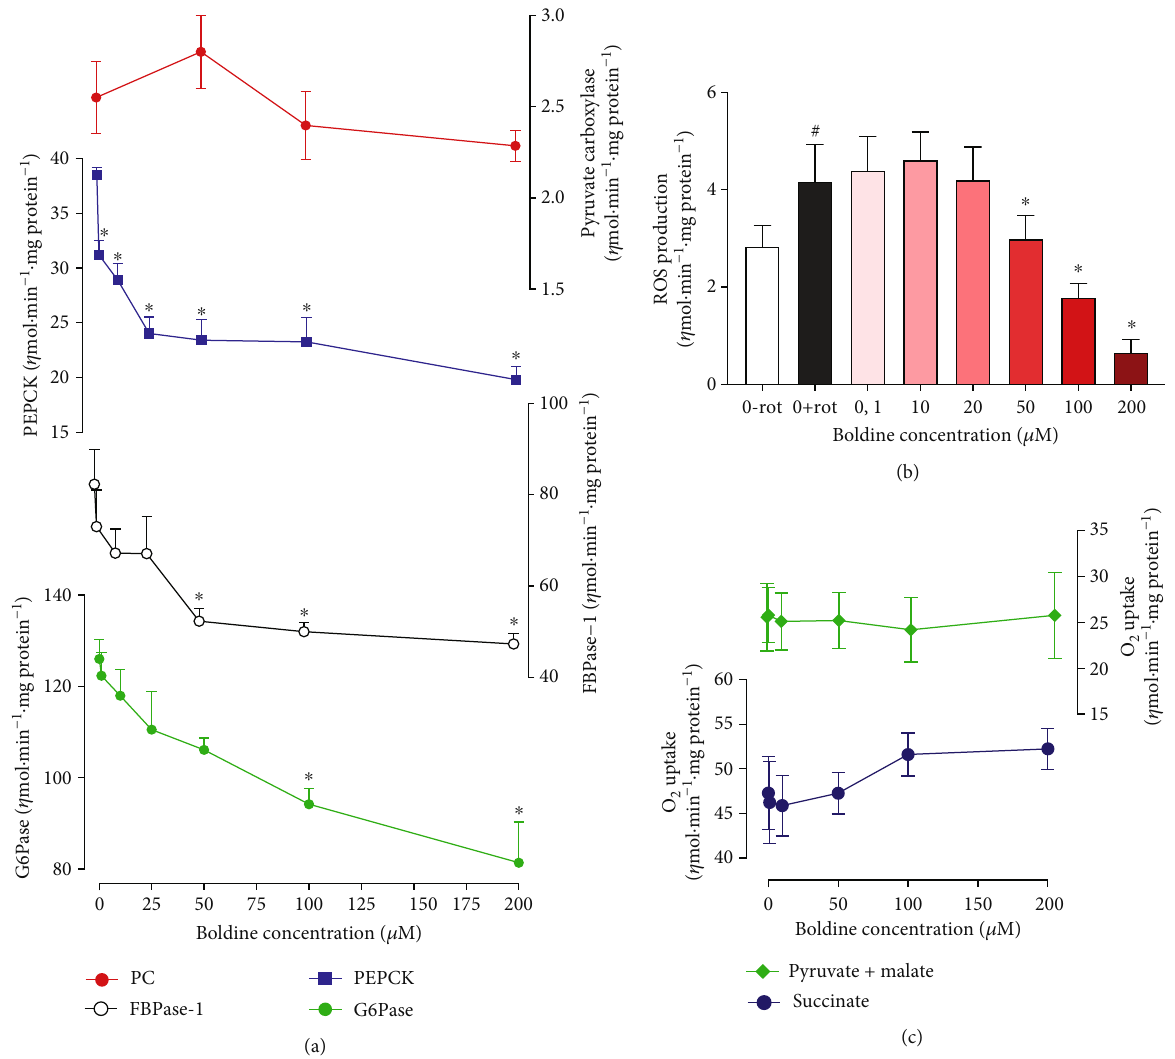
Figure 7: Concentration dependences of the e ff ects of boldine on regulatory enzymes of the gluconeogenic pathway (a), ROS production (b), and mitochondrial respiration (c). Experimental procedures were described in the Materials and methods. (a) Values are means ± mean standard errors of 4 to 6 assays. Asterisks ( ∗ ) indicate statistical signi fi cance in comparison with the control condition (Student- Newman-Keuls, p ≤ 0 : 05 ). (b, c) Mitochondria of the rat livers were isolated as described in the Materials and methods. Values are means ± mean standard errors of 4 to 6 assays. In (b), 0-rot: without boldine and rotenone; 0+rot: without boldine in the presence of rotenone; all boldine concentrations were evaluated in the presence of rotenone. The symbol # indicates statistical signi fi cance in comparison with 0-rot; ∗ indicates statistical signi fi cance in comparison with the stimulated condition (0+rot) (Student-Newman-Keuls, p ≤ 0 : 05